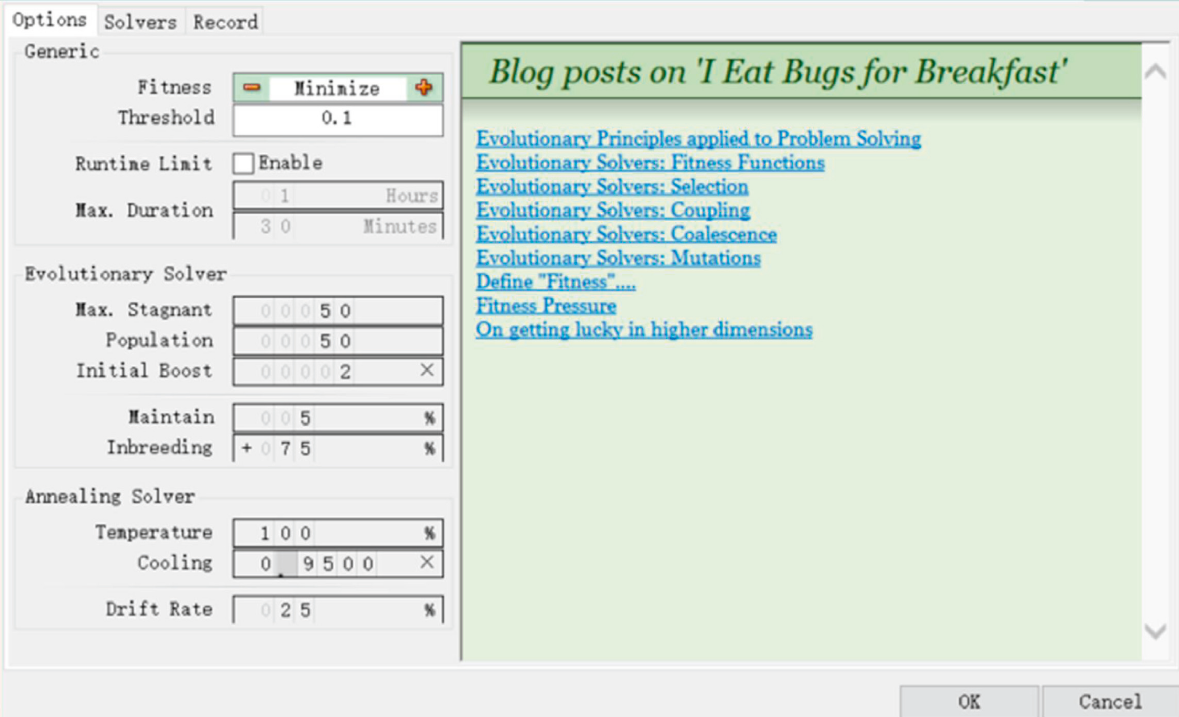
Figure 11: “Galapagos” component